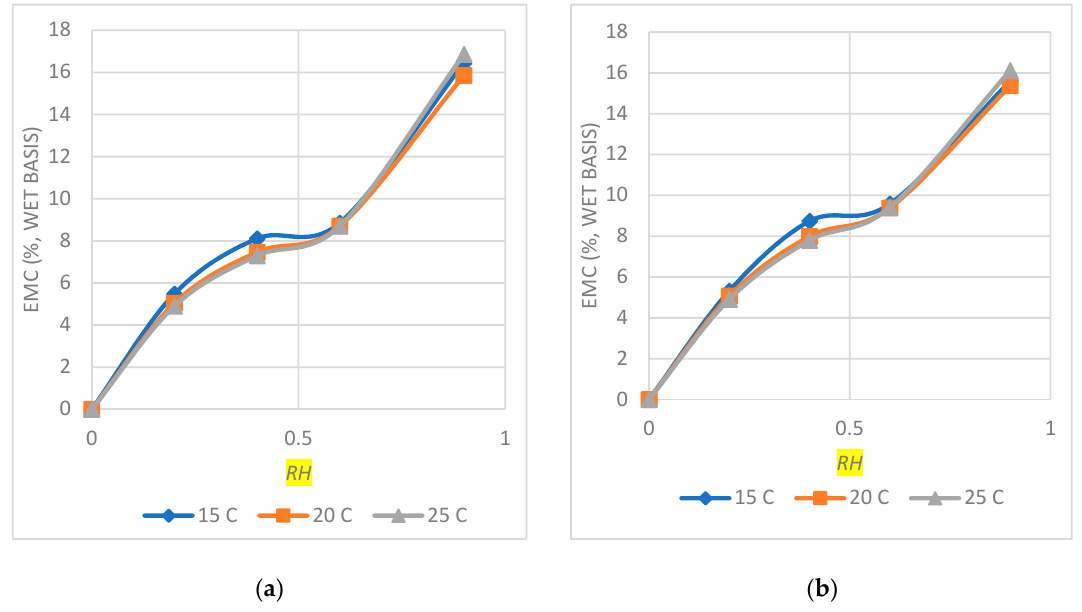
Figure 1. Effect of the temperature on the equilibrium moisture content of the mixed pellets: ( a ) spruce–switchgrass and ( b ) pine–switchgrass.